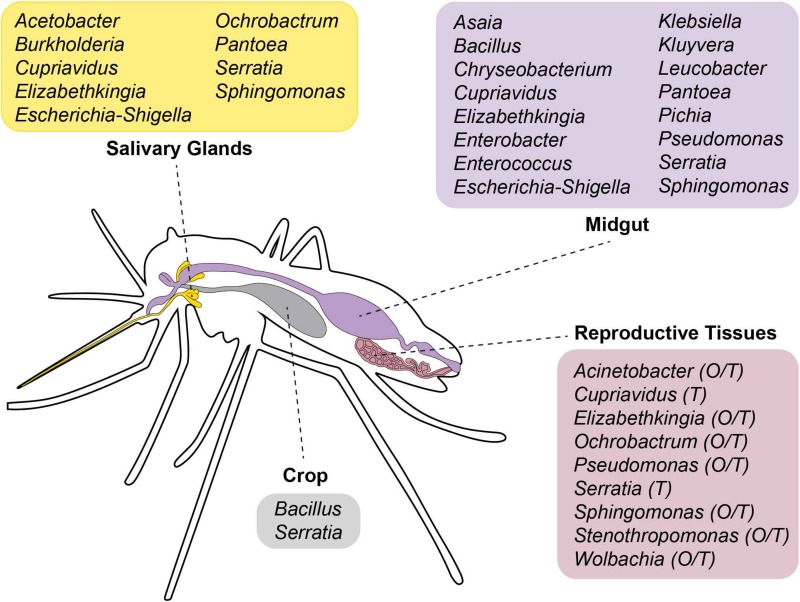
Scheme showing the tissue localization of bacterial genera so far identified in Aedes spp. mosquitoes. O, ovaries; T, testes.